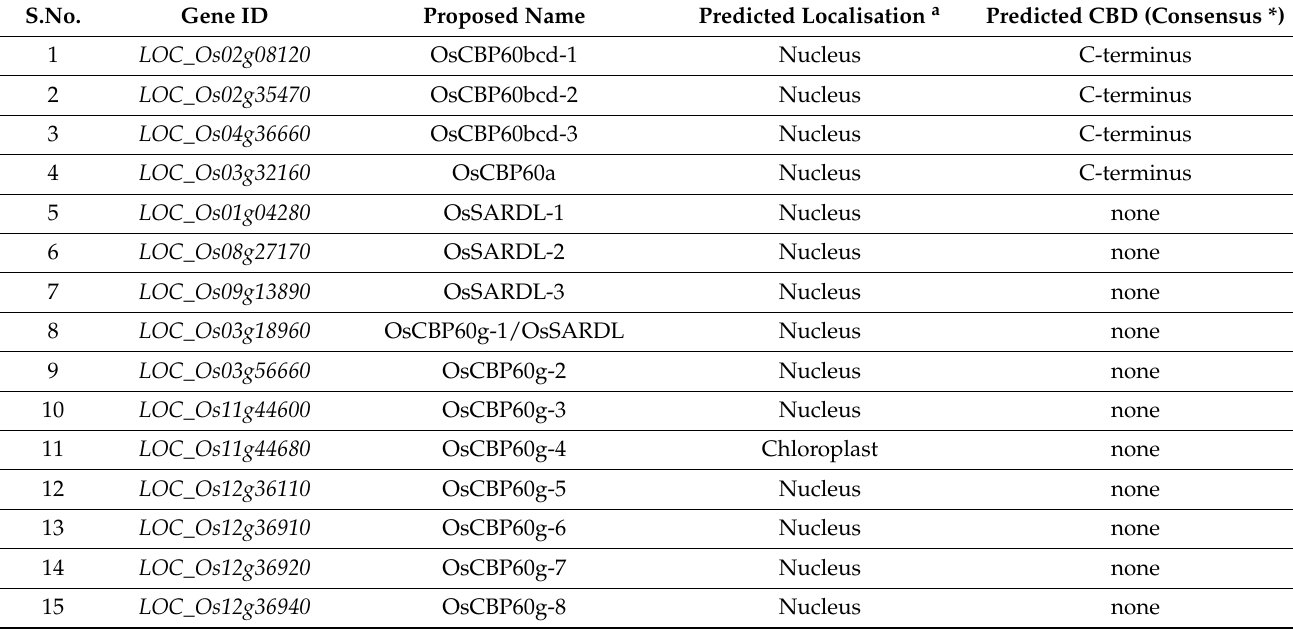
Table 1. Full list of OsCBP60 gene loci with proposed systematic names, predicted subcellular localization, and location of CBD in OsCBP60